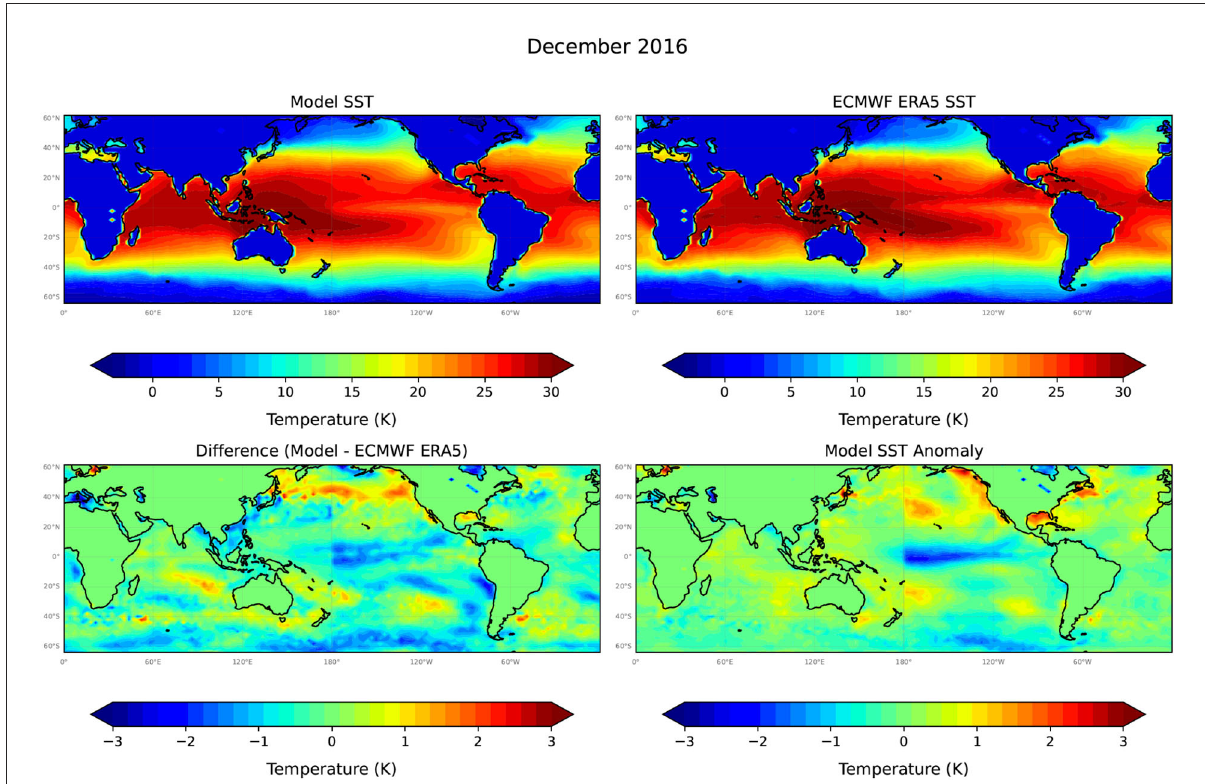
FIGURE6 The model predicted SST at +12 months (December 2016), from a model forecast initiated in December 2015, the corresponding target ERA5 SST data set, the difference between the model predictions and the target, and the model predicted SST anomaly. Note the different, much higher resolution temperature scale used to plot model differences and SST